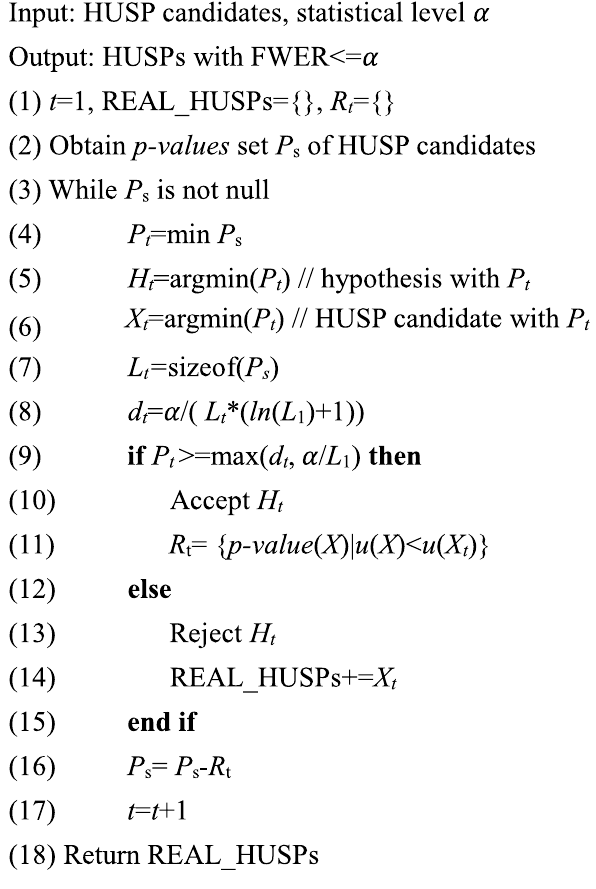
Fig. 6 Procedure of HUSP-Test